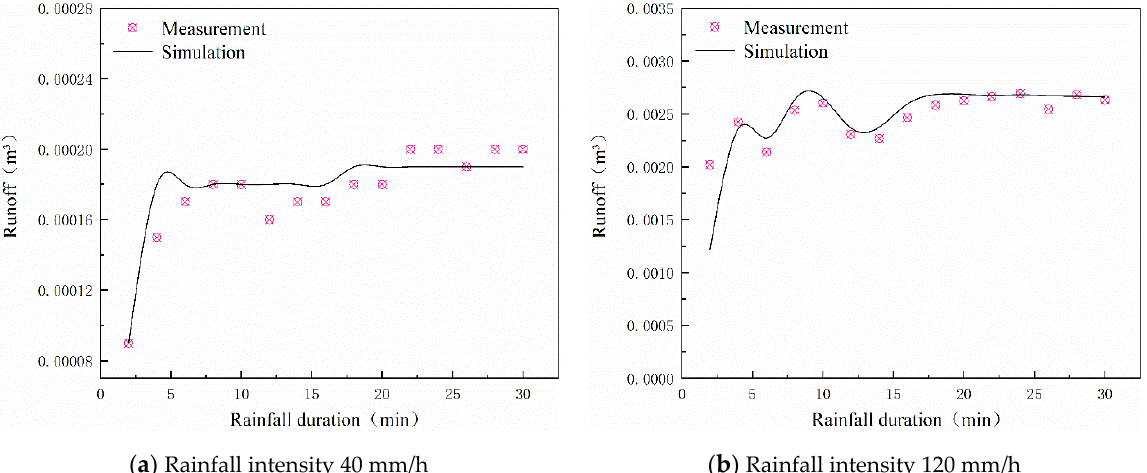
Figure 12. Comparison between measured and simulated runoff rates under different rainfall intensities (loess test steel trough is 2 m).